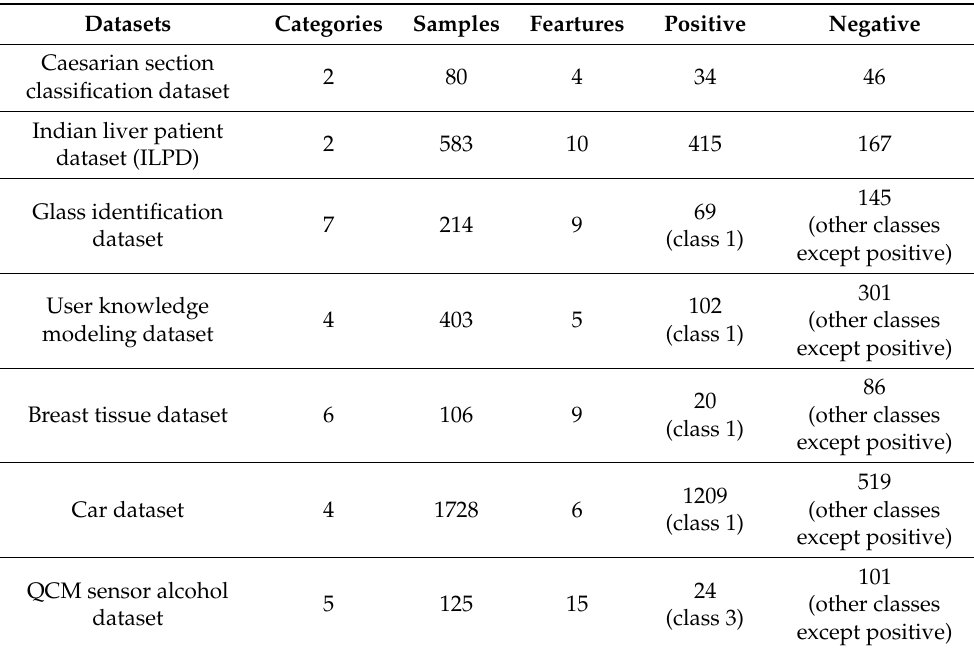
Table 2. The multi-class-dataset-related